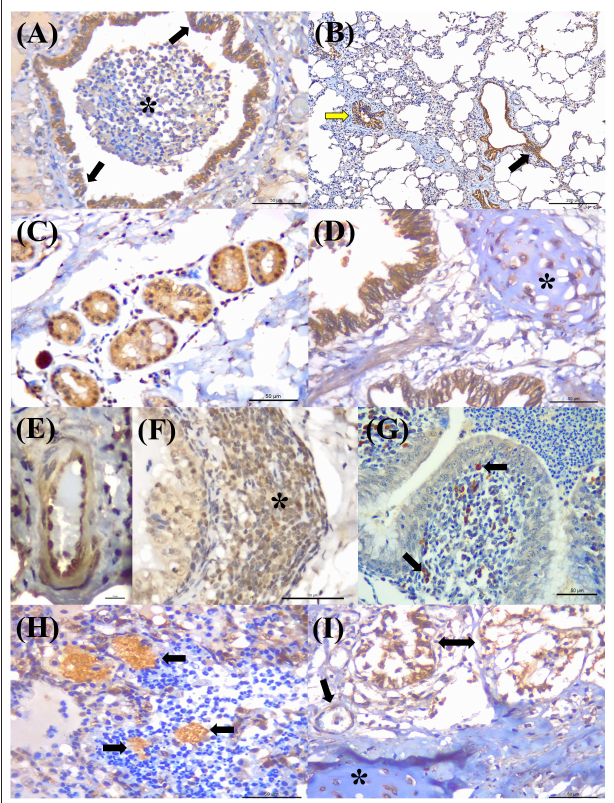
FIGURE 3 | Immunohistochemical detection Mycoplasma bovis antigens in cattle with bovine respiratory disease. (A) There is positive intracytoplasmic immunoreactivity to M. bovis antigens in the normal bronchiolar epithelium (arrows) of a cow with bronchopneumonia (asterisk). (B) Observe positive immunoreactivity at the respiratory (yellow arrow) and terminal bronchiole (black arrow) of a cow with interstitial pneumonia. (C) There is positive reactivity at the mixed peribronchial glands. (D) Observe positive immunoreactivity within chondrocytes of the hyaline cartilage (asterisk), (E) endothelium cells, (F) lymphocytes (asterisk), (G) macrophages, (arrow), and bronchus-associated lymphoid tissue. (H) There is positive immunolabeling within accumulations of pleomorphic organism (arrows) in the lung with suppurative bronchopneumonia. (I) Observe positive immunolabeling in necrotic peribronchial glands (two-headed arrow), normal endothelium cells (arrow), and chondrocytes of the hyaline cartilage (asterisk). Immunoperoxidase counterstained with hematoxylin. Bar: (A,C,D,F–I) 50 µ m; (B) 200 µ m; (E) 10 µ m.